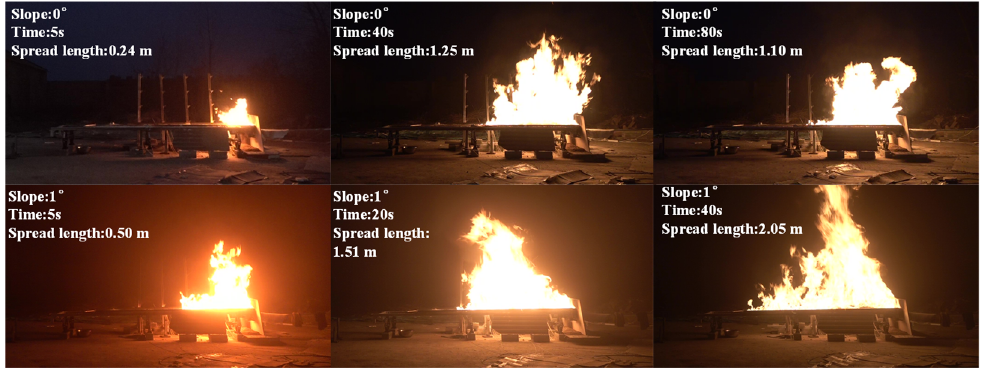
Figure 3. Images of the spill fire at various moments.